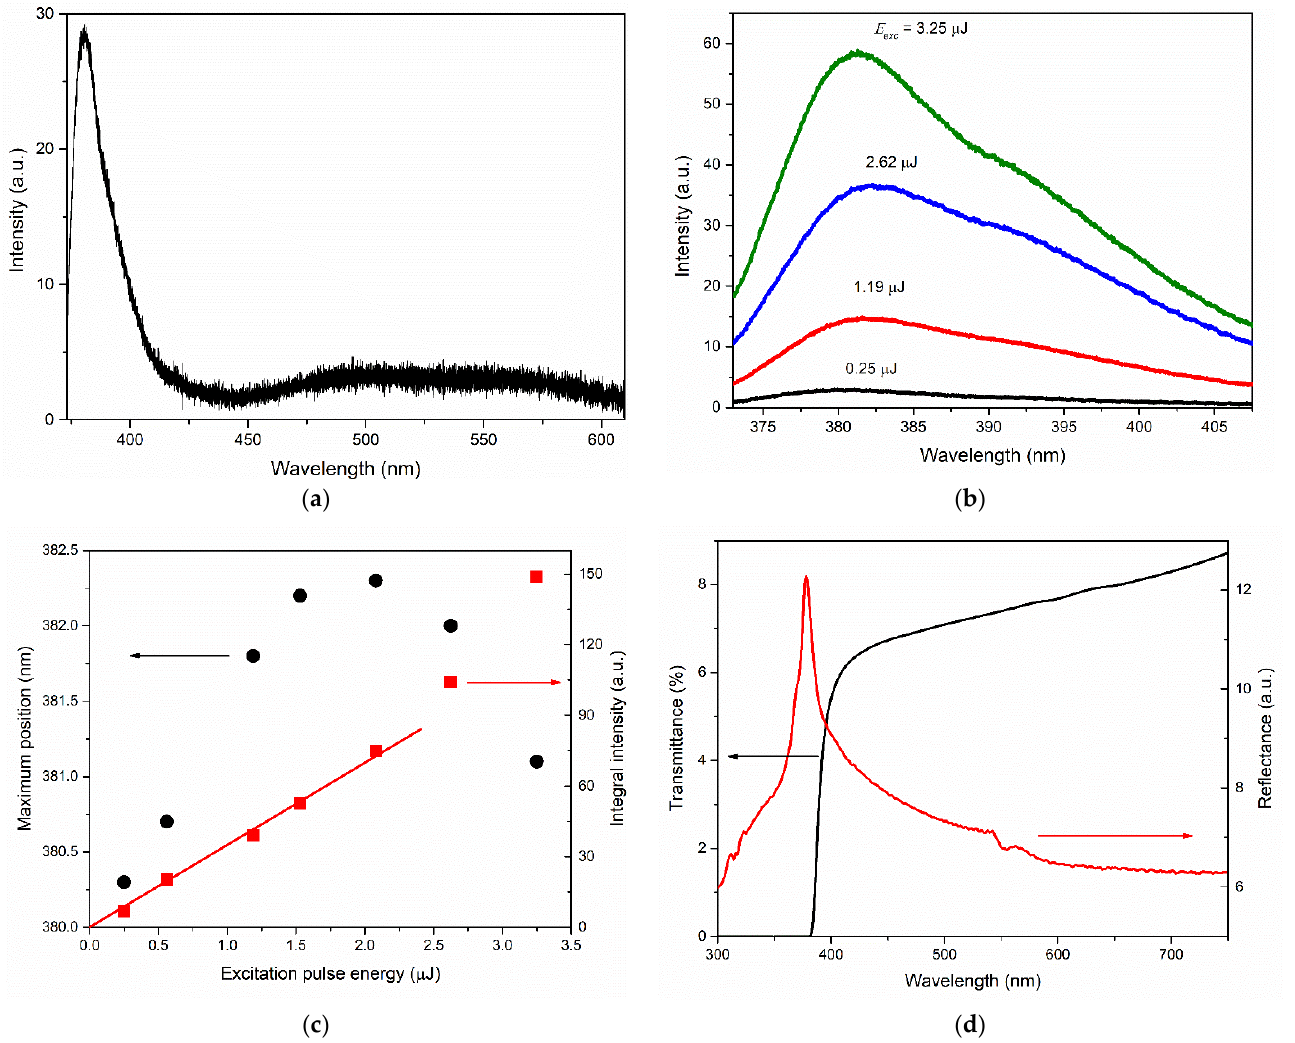
Figure 5. Optical and emission properties for the type-A film: ( a ) PL spectra recorded at E exc ≈ 0.25 µJ; ( b ) NBE emission spectra at different E exc ; ( c ) dependence of NBE emission integral intensity (red squares) and maximum position (black circles) on E exc ; ( d ) transmittance (black) and directional reflectance (red) spectra.